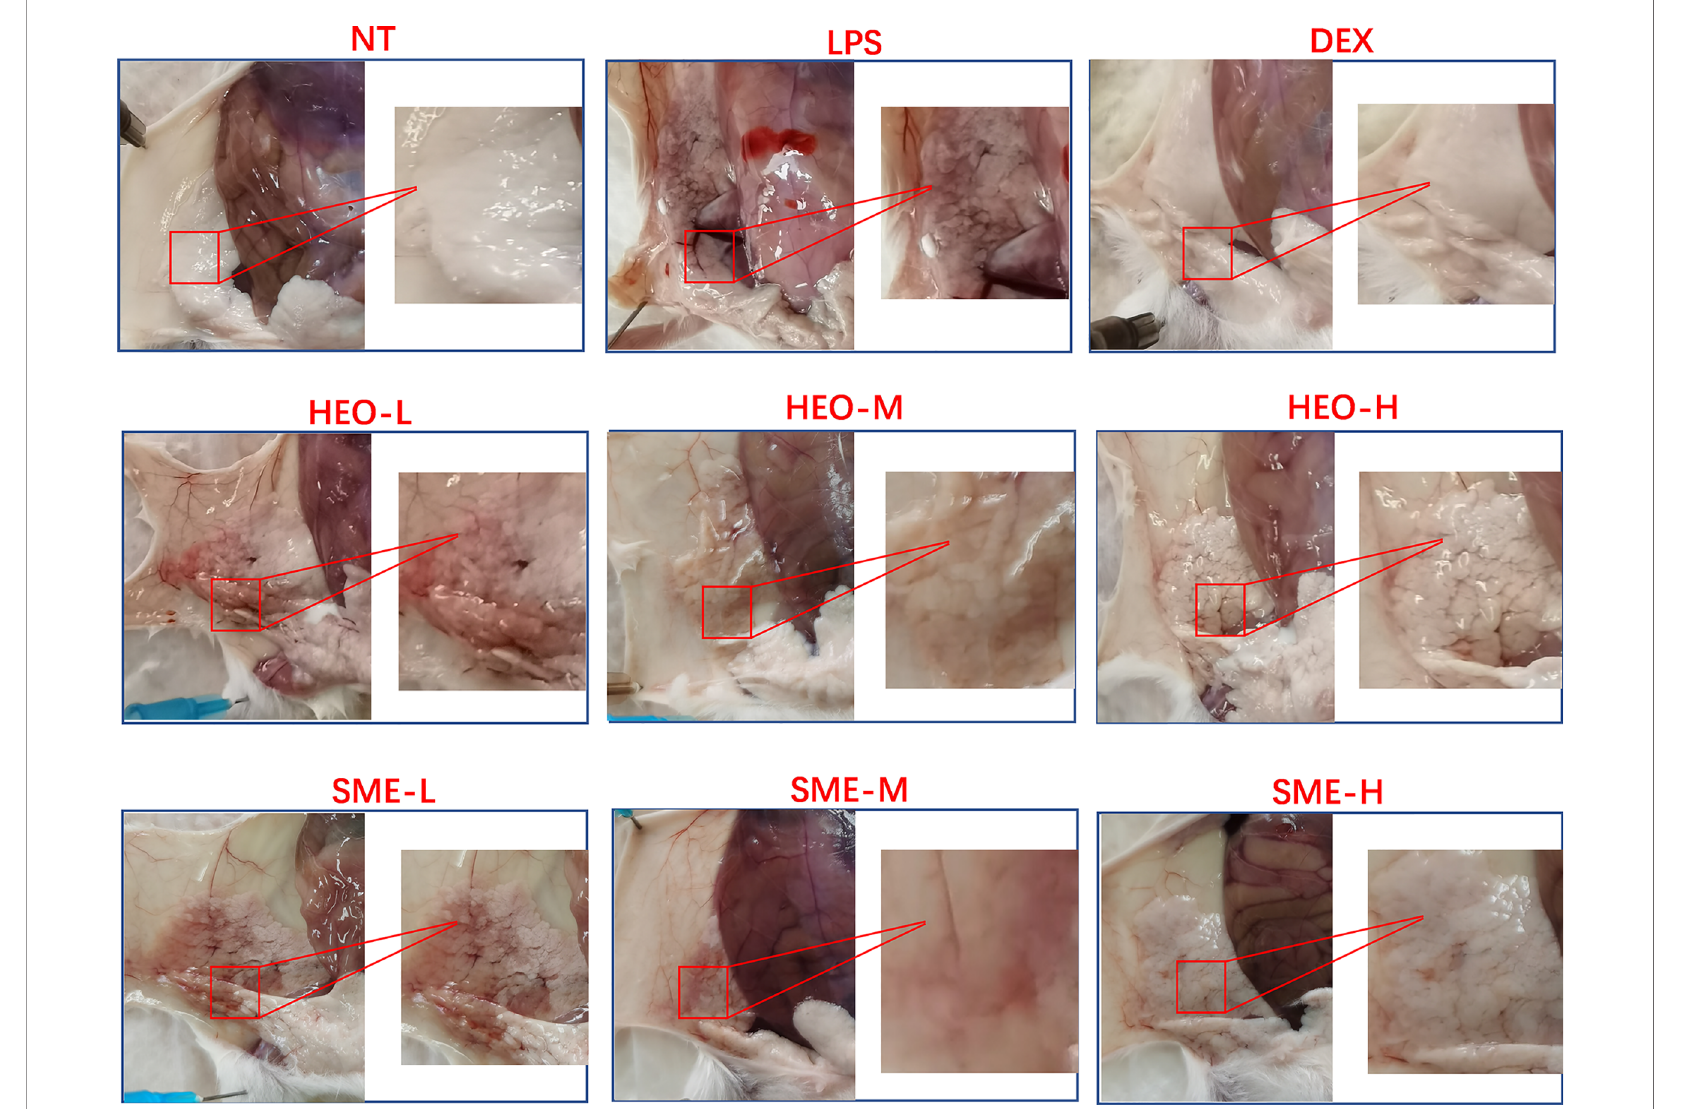
FIGURE 2 | Morphology of mammary gland tissue in LPS-induced murine